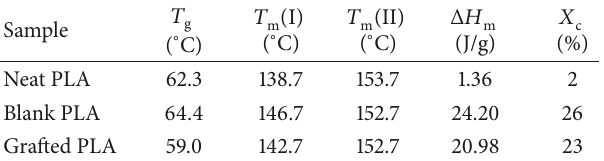
Table 2: Thermal properties derived from DSC (1st heating) experiments of neat, blank, and grafted PLA